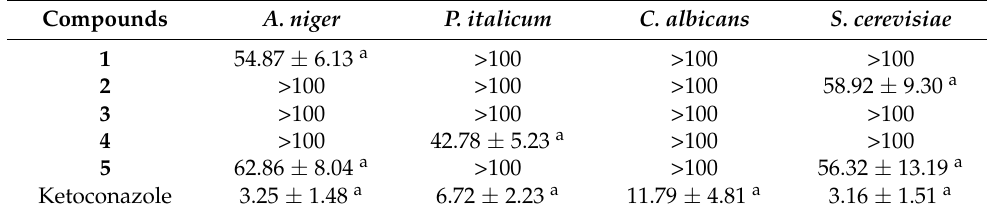
Table 5. MIC values of compounds 1 – 5 in µ g/mL against four fungi